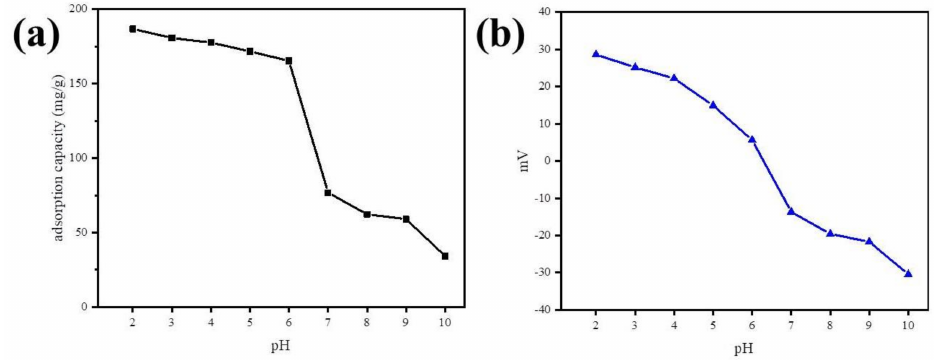
Figure 13. ( a ) E ff ect of solution pH on DCF adsorption by Fe@BC and ( b ) zeta potential of Fe@BC at di ff erent